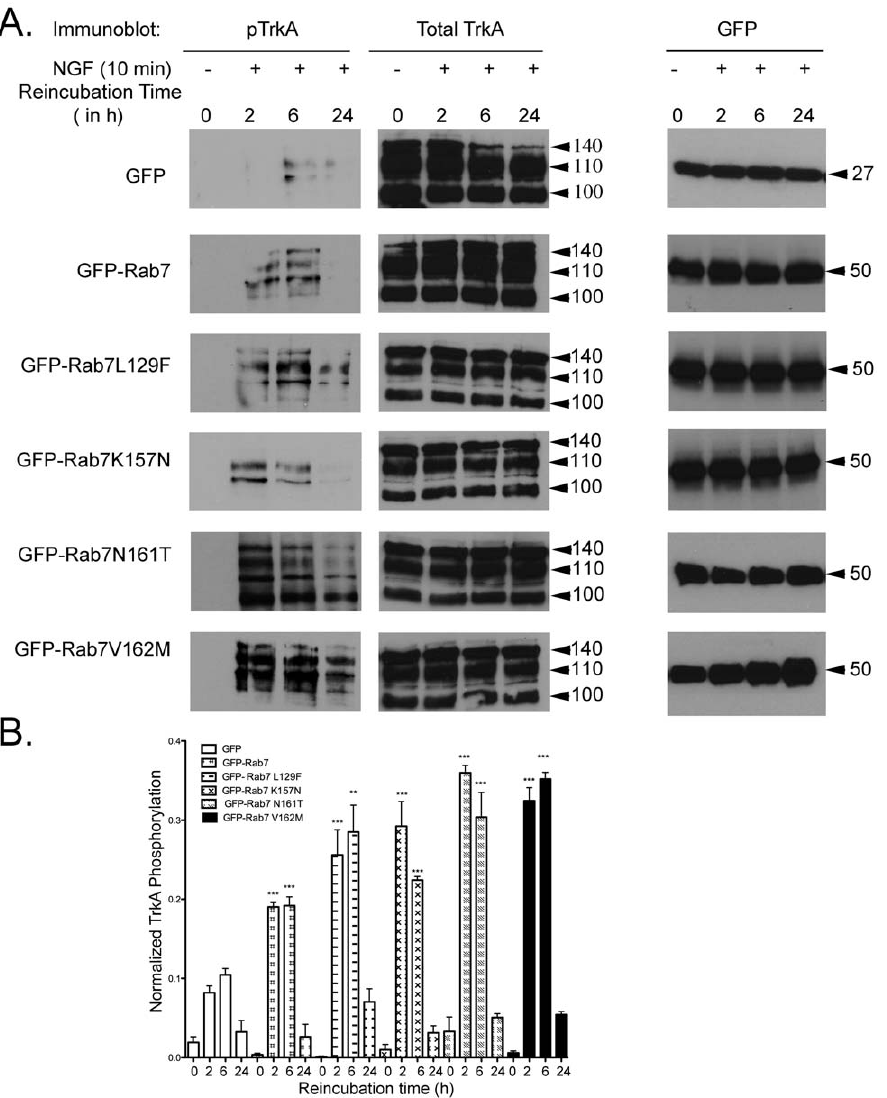
Figure 2. Cells Expressing Rab7 CMT2B Mutants Exhibit Higher Levels of Phospho-TrkA Following NGF Stimulation. (A) Transiently transfected PC12 cells expressing GFP, GFP-Rab7wt, GFP-Rab7L129F, GFP-Rab7K157N, GFP-Rab7N161T, GFP-Rab7 V162M were briefly stimulated with NGF (200 ng/ml) followed by surface stripping of ligand and reincubation in 0.1% BSA-DMEM for 2 h, 6 h and 24 h respectively. Subsequently, cells were lysed and equal amounts of protein were immunoblotted and probed for total and phosphorylated TrkA. Significantly, higher levels of phosphorylated TrkA were found at 2 h and 6 h. Equal amounts of protein from cell lysates were probed with antibodies against GFP. GFP-Rab7wt and GFP-Rab7 CMT2B mutant proteins are uniformly expressed in PC12 cells under these conditions as shown in the adjacent representative blot. (B) Films from four independent experiments were quantified by Image J analysis. Bar graphs show pTrkA in GFP-Rab7wt and CMT2B mutant expressing cells. In each case the amount of pTrkA was normalized to the amount of GFP protein expressed. The bar graph shows the fold-change in pTrkA as a function of pTrkA in the GFP only control at each respective time point. Error bars indicating mean 6 S.E.M., n=4, **p , 0.01, ***p , 0.001. For detailed numerical values see Table